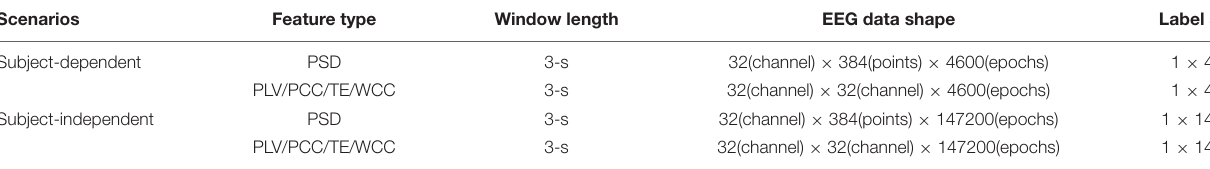
TABLE 1 | EEG data and label format. Scenarios Label shape